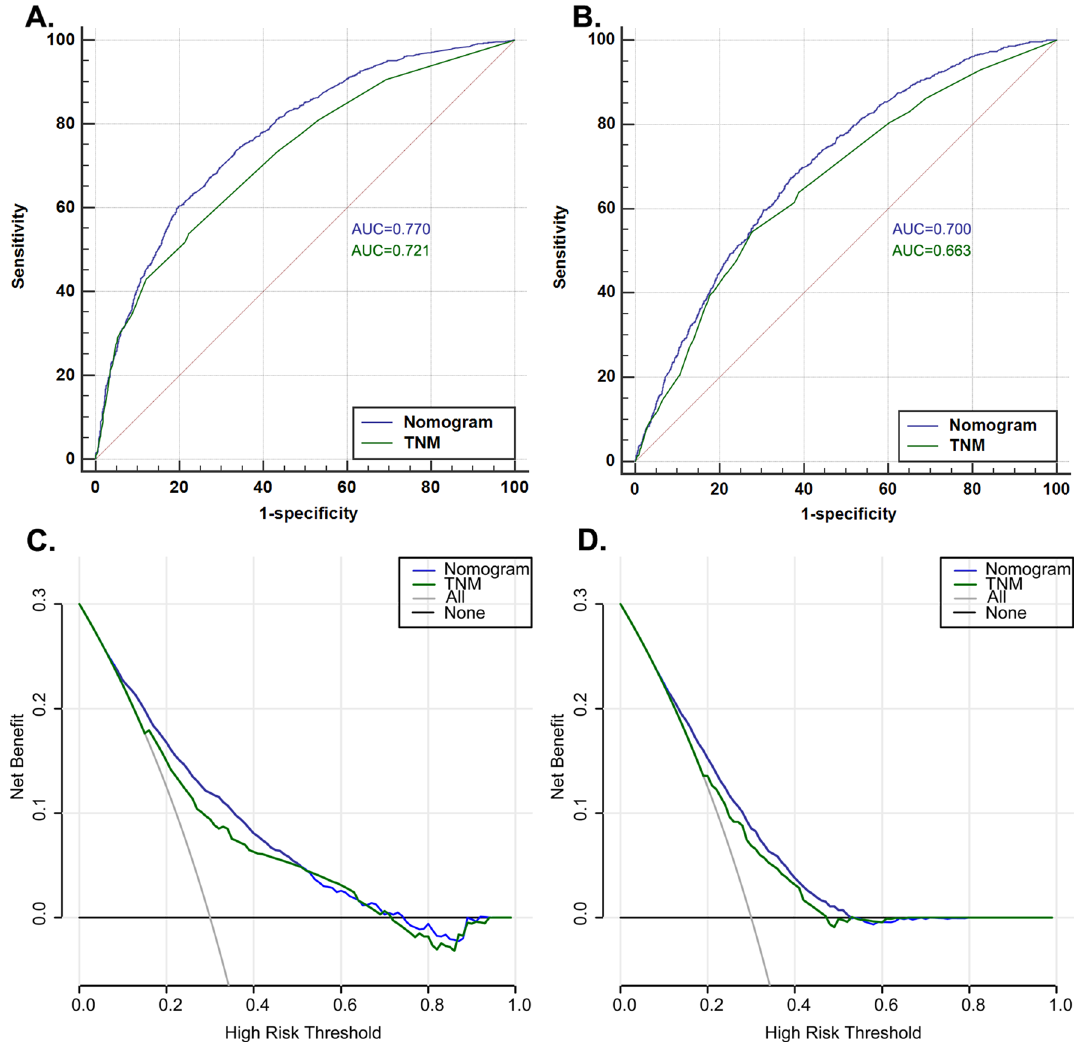
Figure 3. Receiver operating characteristic (ROC) and decision curve analysis (DCA) curves detect the predictive value of two nomograms in GCC prognosis. ( A ) ROC curve for overall survival (OS); ( B ) ROC for cancer-specific survival (CSS); ( C ) DCA for overall survival (OS); ( D ) DCA for cancer-specific survival (CSS). Training Characteristics